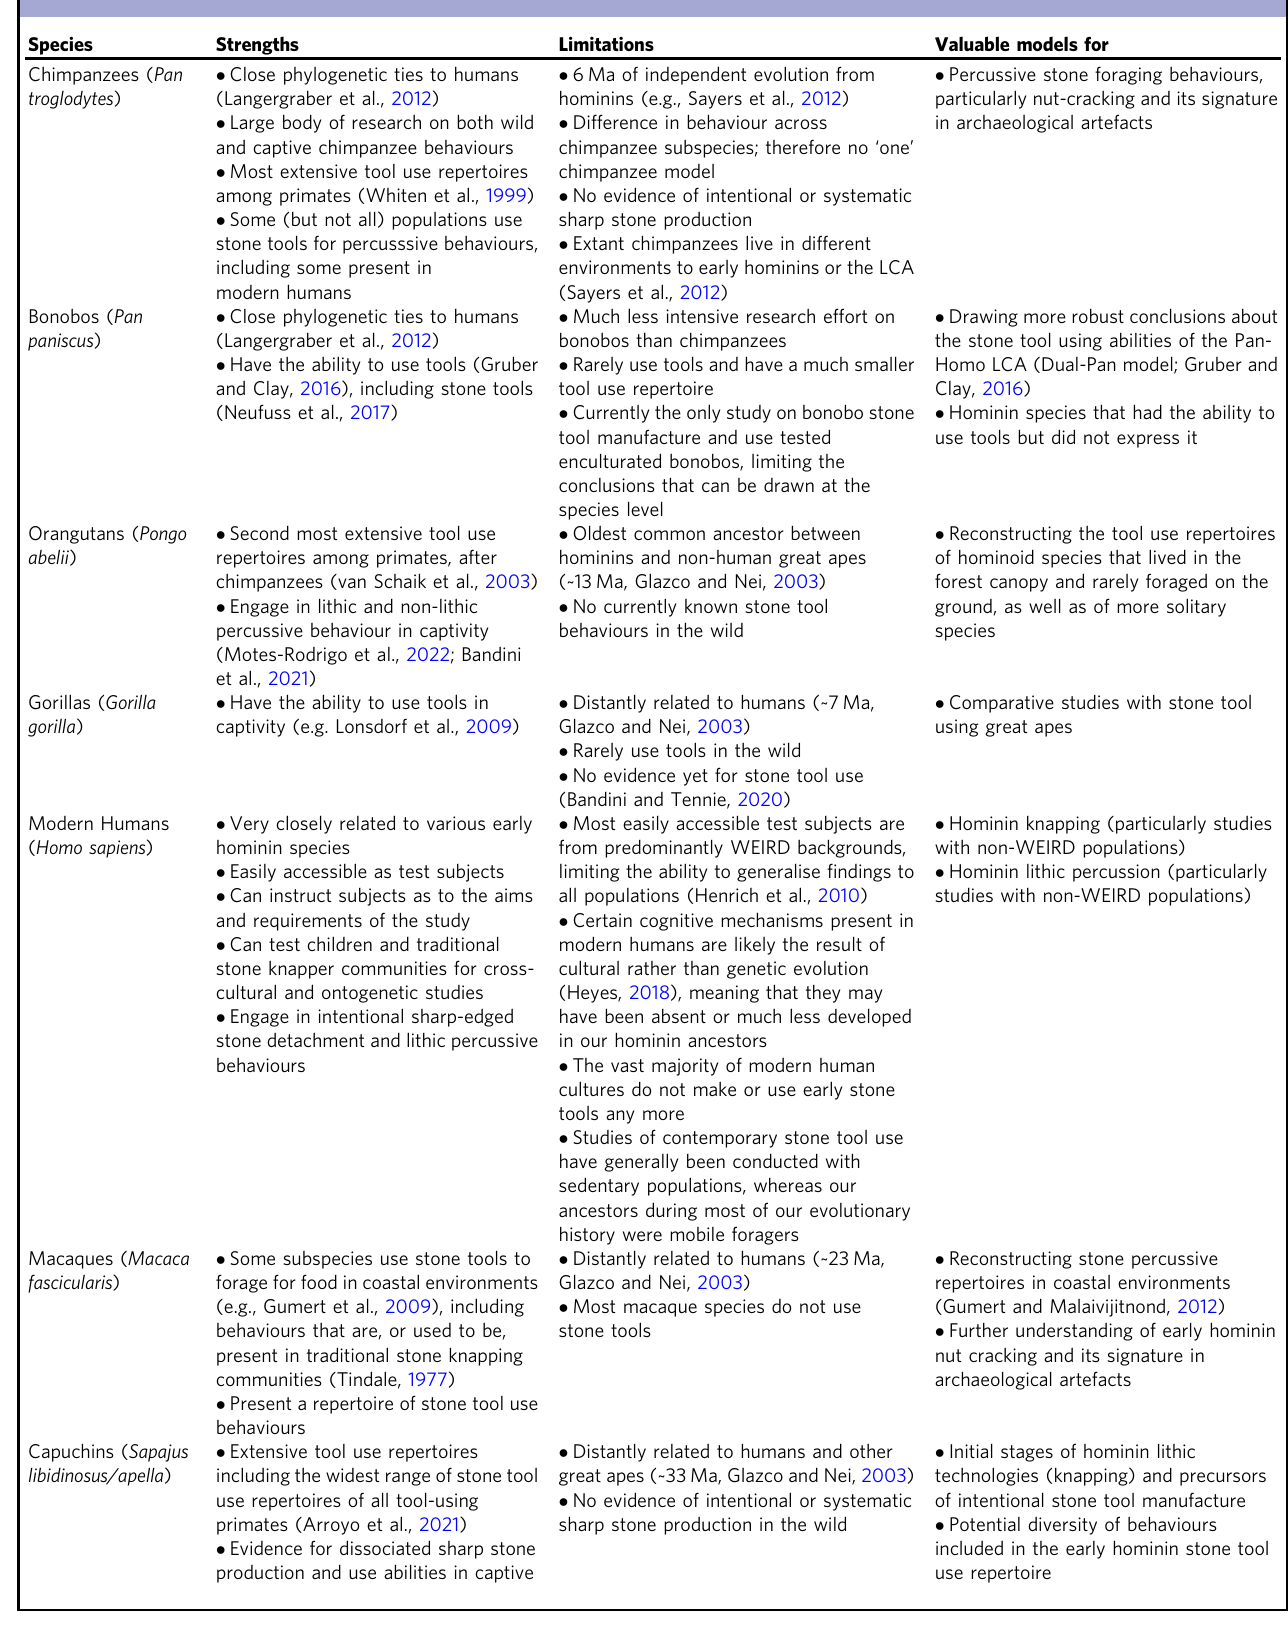
Table 1 Summary table of the strengths and limitations of using different primate species as models of early hominin stone behaviours as well as a description of the most appropriate use of each species in comparative studies aimed at reconstructing early hominin stone